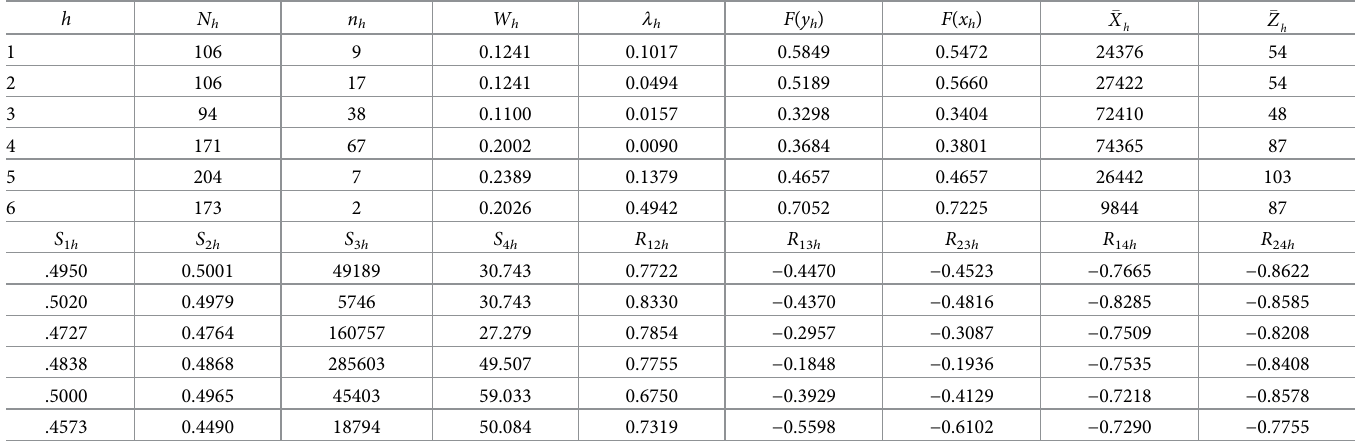
Table 11. Summary statistics for Population